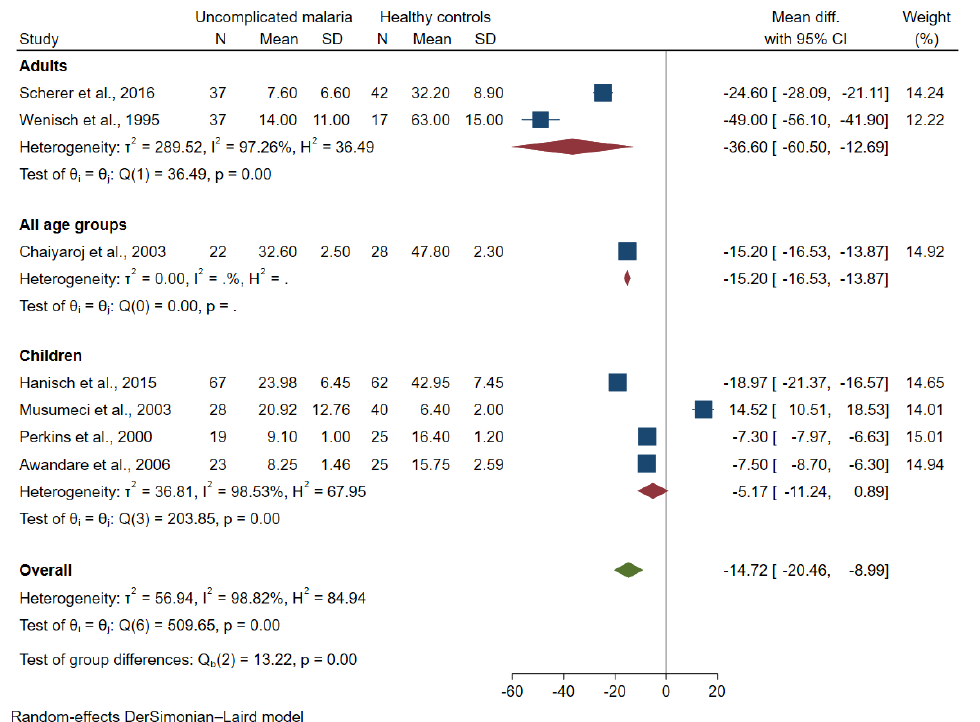
Figure 3. Forest plot demonstrating a difference in mean TGF-β levels (pg/mL) in uncomplicated malaria and healthy controls by continents [26,27,33,38–40,42]. Grey y -axis line, line of no effect size; blue square boxes, mean TGF-β levels from each study; line on the left and right of blue square boxes, 95% CI; green diamond; overall effect size; crimson diamond, overall effect size in each subgroup; I 2 , H 2 and τb 2 , heterogeneity measures.